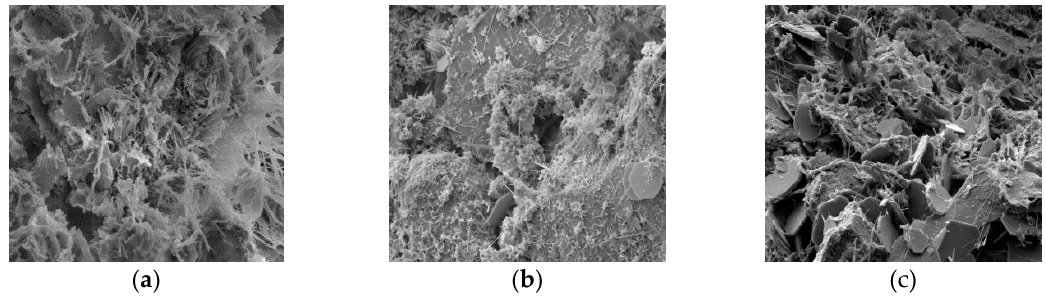
Figure 4. Microscopic appearance of the calcium silicate hydrate, calcium hydroxide, and calcite crystal. ( a ) calcium silicate hydrate; ( b ) calcium hydroxide; ( c ) calcite crystal.